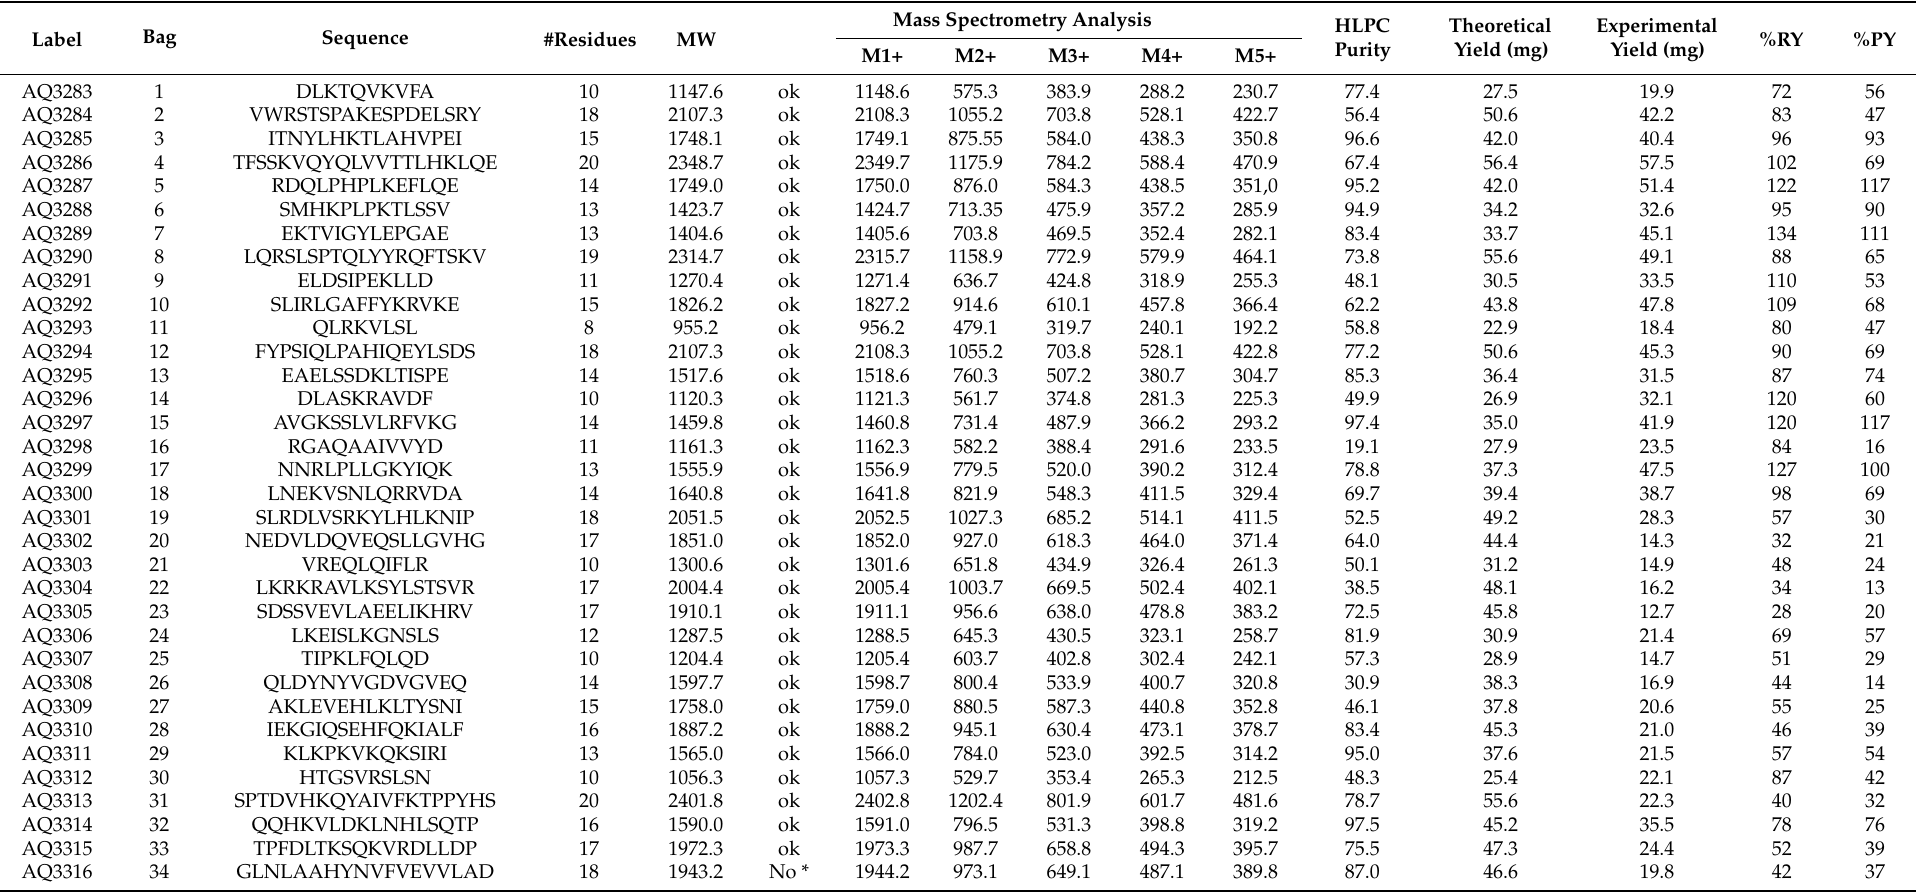
Table 2. Synthesized peptides and their main